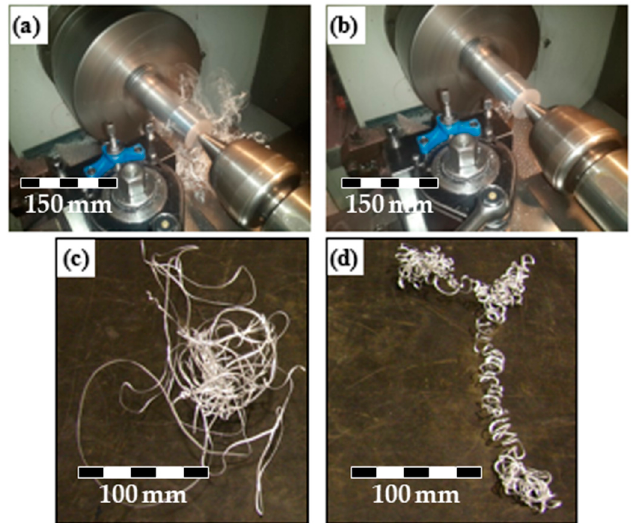
Figure 12. Generated chips ( a ) turning test using insert without a chip breaker with generated chips wrapped around the workpiece, ( b ) turning test with insert including chip breaker, where chips are evacuated, ( c) straight chips as a result of turning test with original insert geometry, no chip breaker, and ( d ) curly chips as a result of turning test with insert including chip breaker.